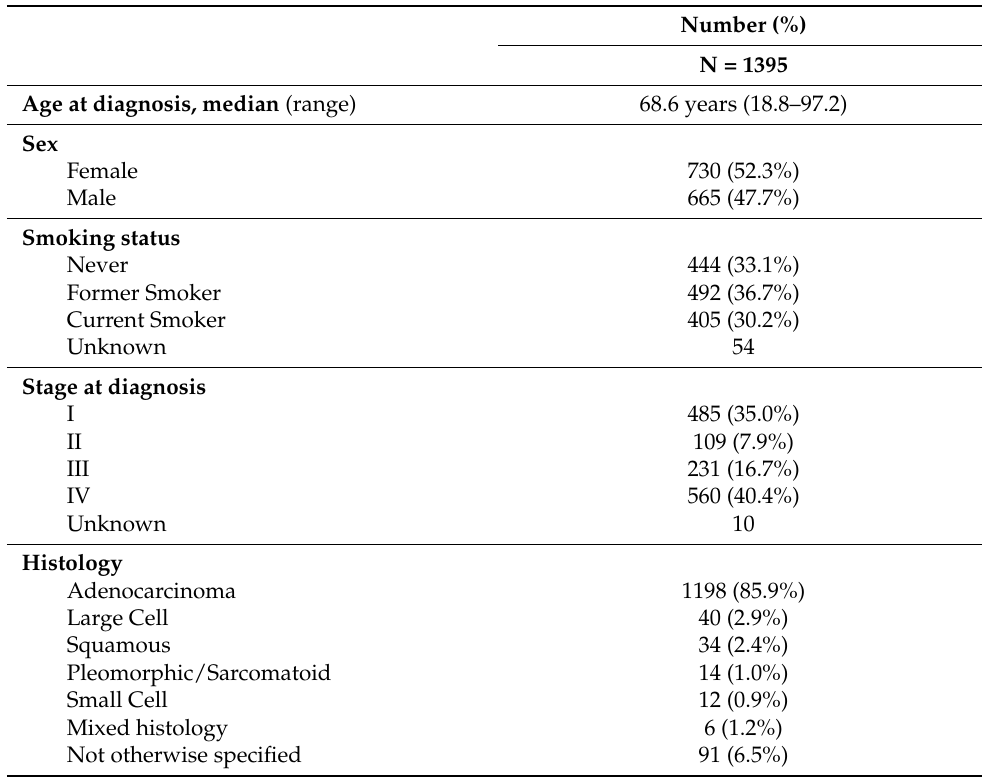
Table 1. Patient and disease characteristics (N = 1395 patients).